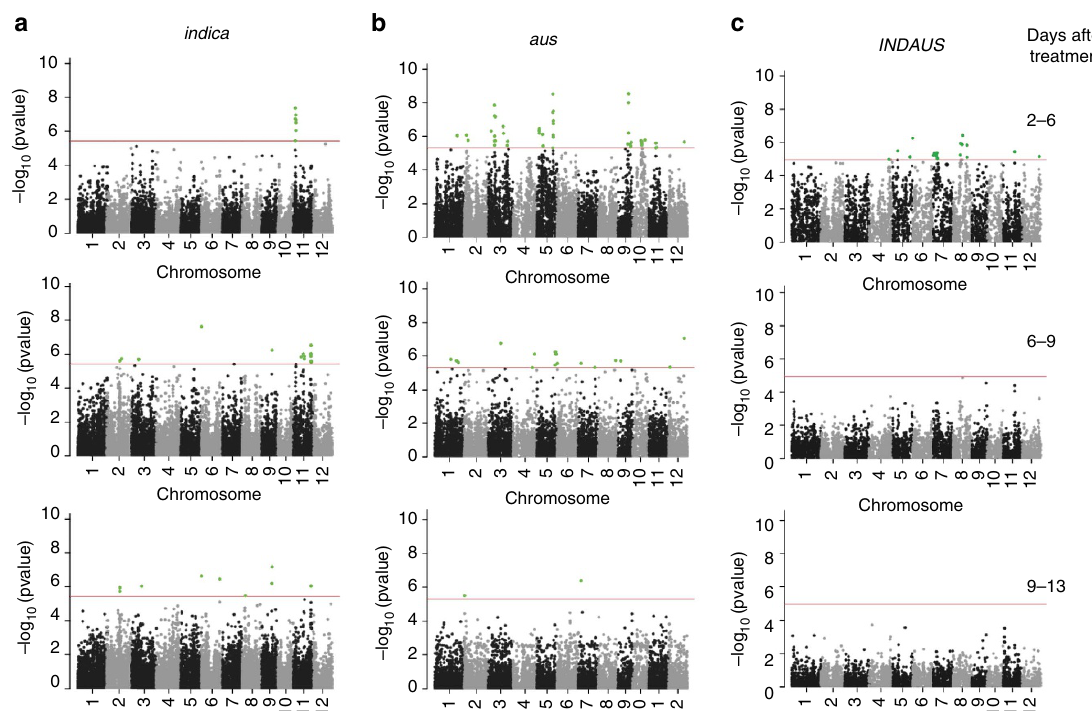
Figure 3 | Marker-by-treatment interaction model using transpiration use efficiency in response to salinity. SNPs are highlighted in green if they reach genome-wide significance for association with TUE at each time interval in ( a ) indica , ( b ) aus and ( c ) INDAUS . SNPs associated with TUE are shown at the different time intervals: 2–6, 6–9 and 9–13 days after treatment (panels top to bottom). Horizontal red lines indicate Bonferroni-adjusted threshold of a ¼ 0.05, which corresponded to P ¼ 8.99 (cid:3) 10 (cid:2) 6 , 2.57 (cid:3) 10 (cid:2) 6 and 3.02 (cid:3) 10 (cid:2) 6 for the INDAUS , indica and aus subpopulations,